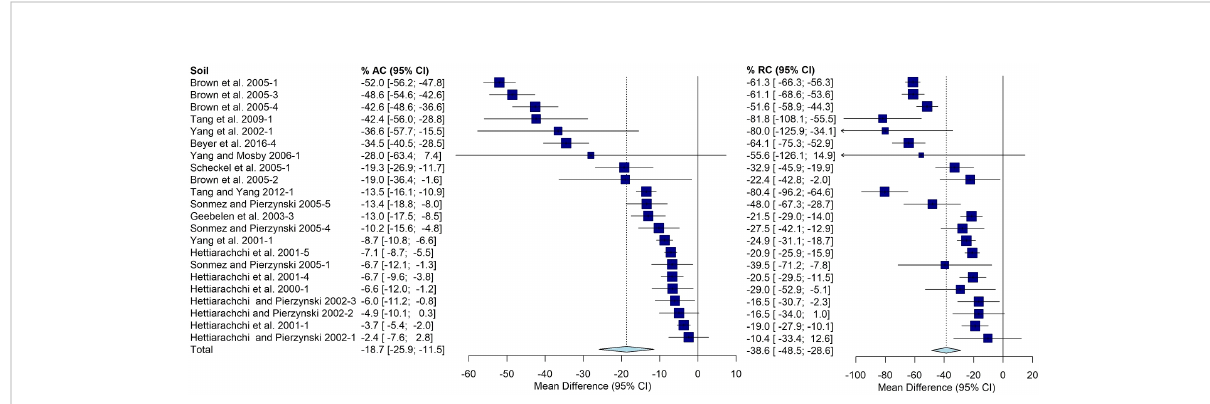
FIGURE 7 Random effects forest plot of AC and RC for soils from Jasper County, MO. Squares represent the mean difference for a soil and error bars are 95% CI. Diamonds represent the 95% CI for summary treatment